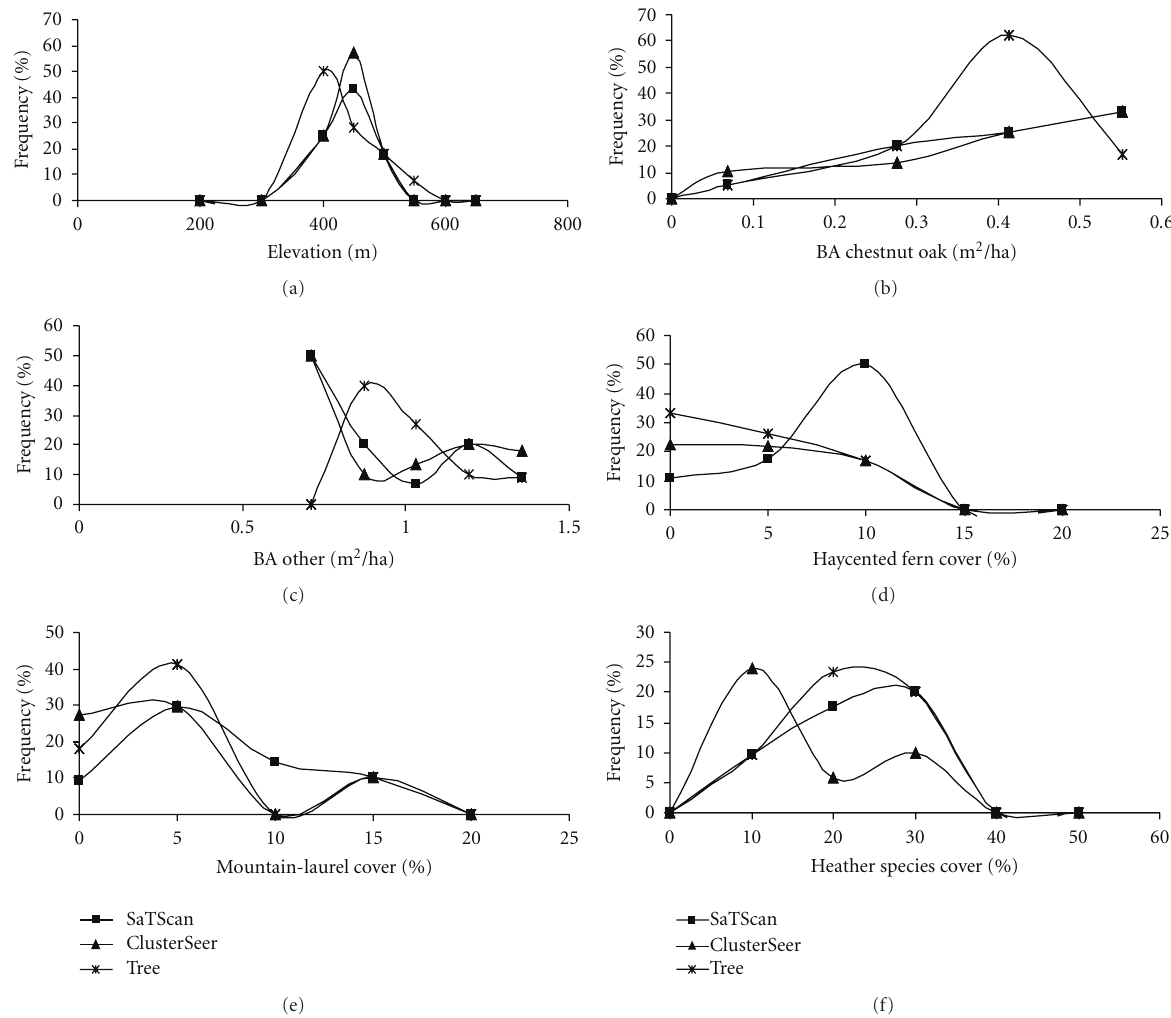
Figure 3: Relative frequency distribution of elevation, overstory basal area of chestnut oak (BA chestnut oak), overstory basal area of other species (BA other), and percentage cover of herbaceous species associated with hotspots identified by three di ff erent methods. Relative frequency was calculated using number of stands identified as hotspots divided by total number of stands within each range for each